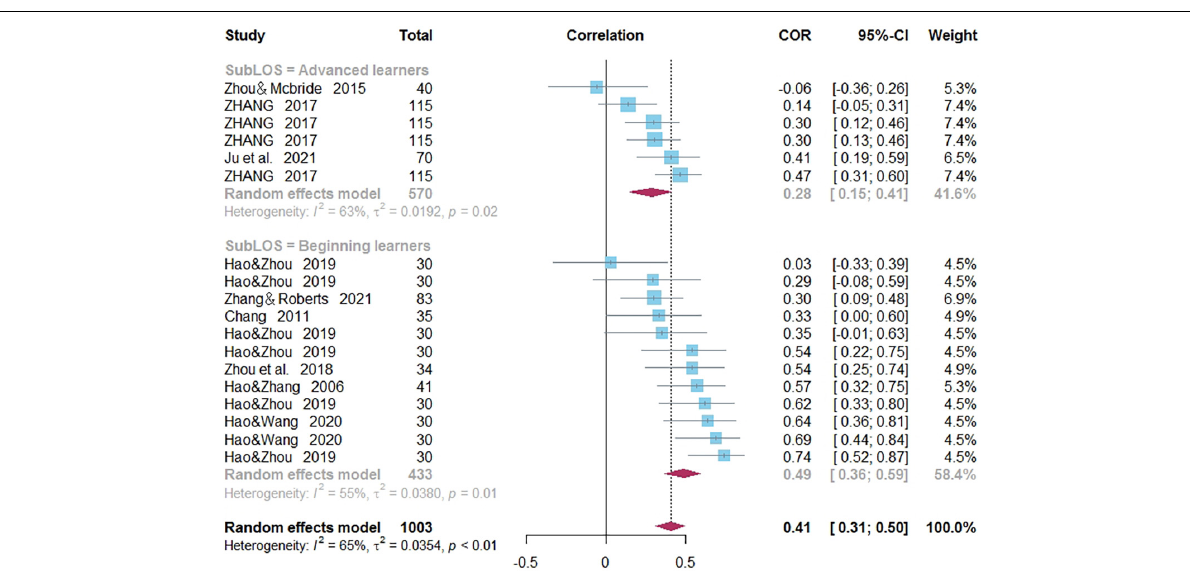
accuracy (Chinese: r = − 0.38, English: r = 0.42) and reading fluency (Chinese: r = − 0.51, English: r = 0.49). RAN is